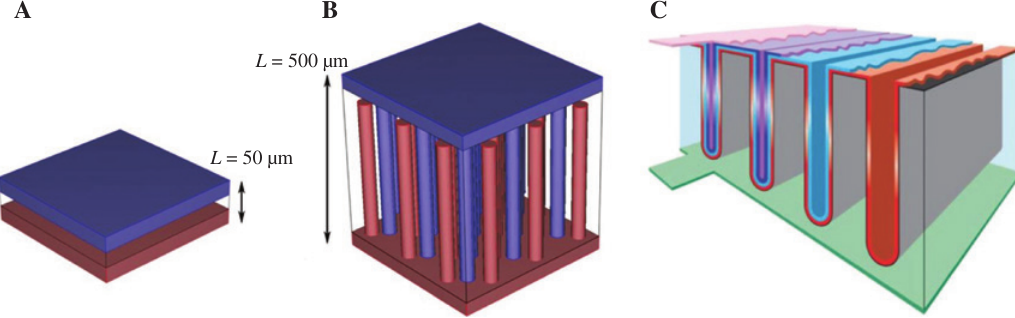
Figure 14: Concepts for electrode designs and arrangements suggested for micro-battery applications. Schematic view of (A) 2D and (B) 3D electrodes [83] and (C) an all solid state lithium-ion micro-battery integrated in a 3D substrate [84].